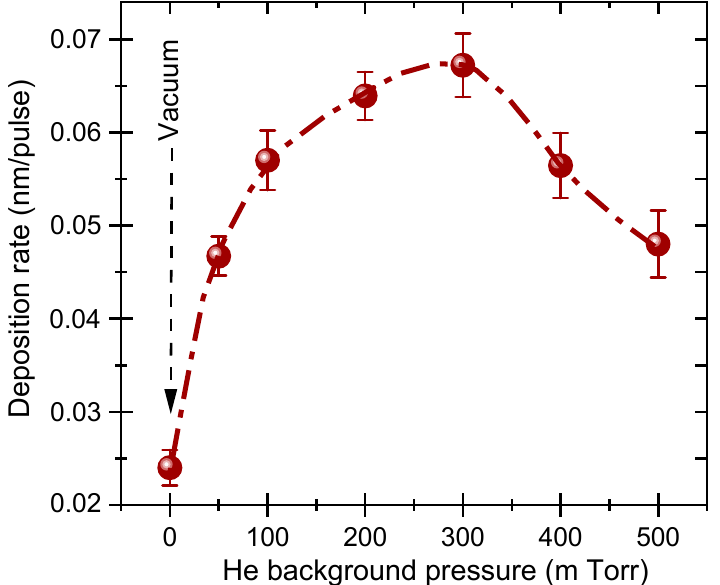
Figure 1. Helium background pressure dependence of the deposition rate of PbS films.